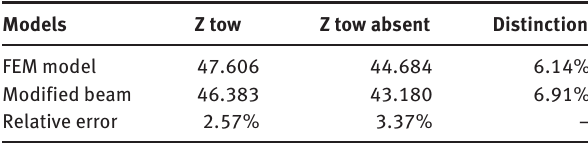
Table 7: The influence of Z